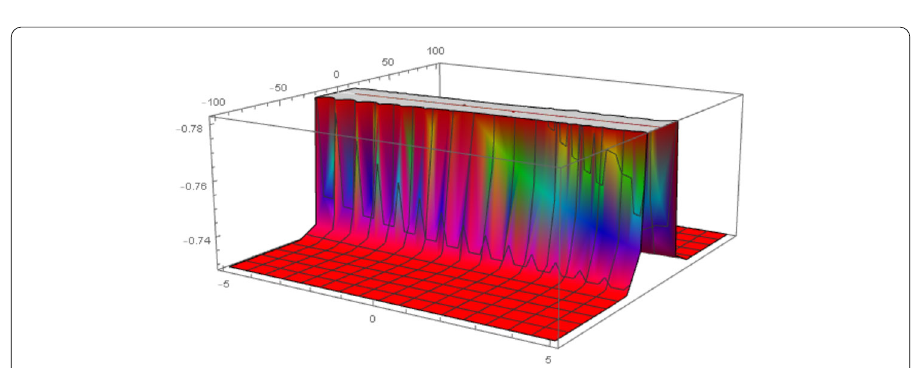
Figure 6 Solitonic solution of u 7 ( η ) for α = 0.30, a 1 = 11, λ = 0.77, b 0 = 1, b 1 = 100